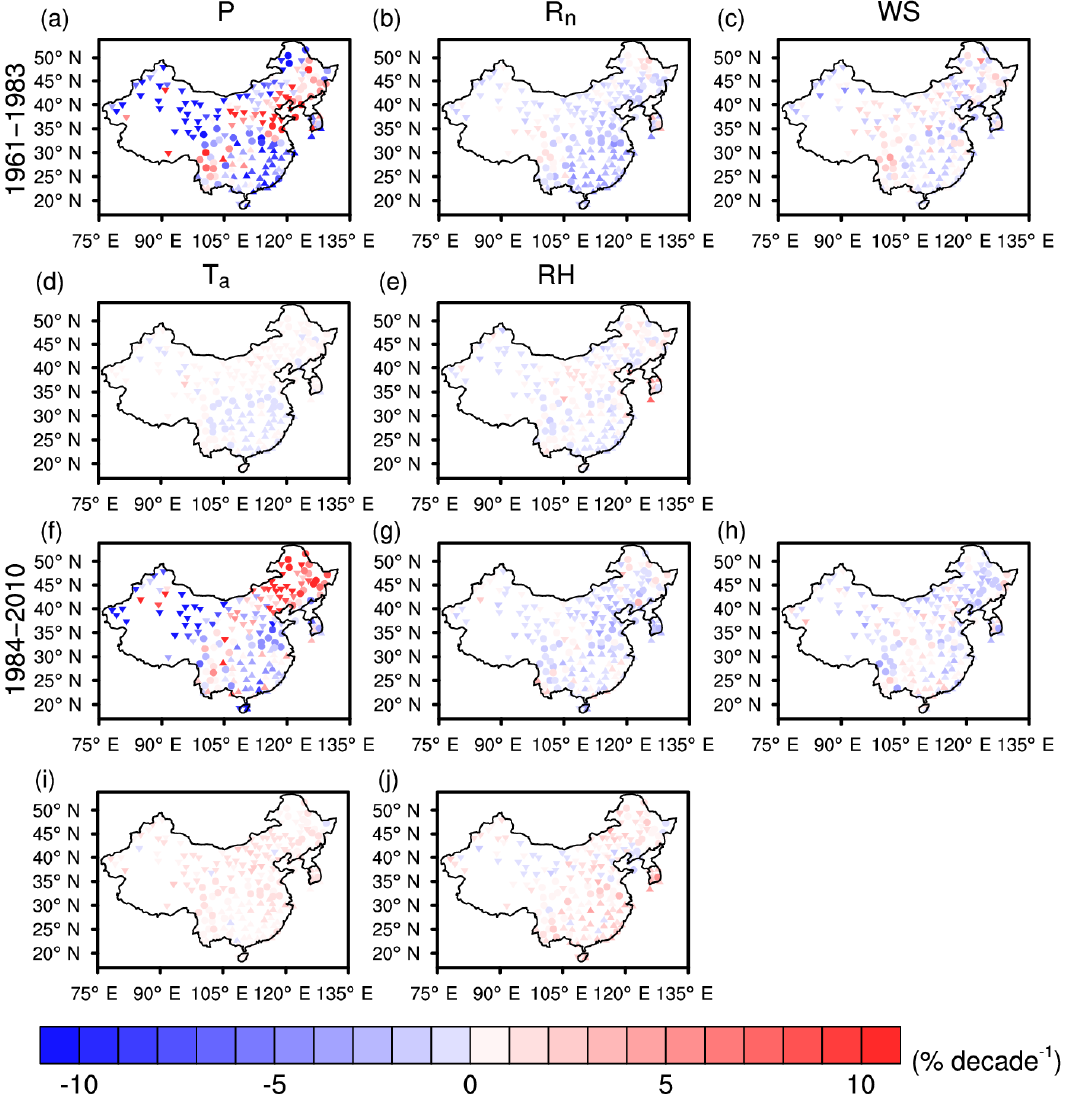
Figure 6. Spatial distributions of the relative influences of five climate parameters on the PET /P trends. (a–e) The spatial distribution of relative influences of the changes in P (a) , R n (b) , WS (c) , T a (d) , and RH (e) on the PET /P trends for the period of 1961–1983. Panels (f–j) as (a–e) but for the period of 1984–2010. Inverse triangles, circles, and triangles represent stations classified as arid, transitional, and humid regions,